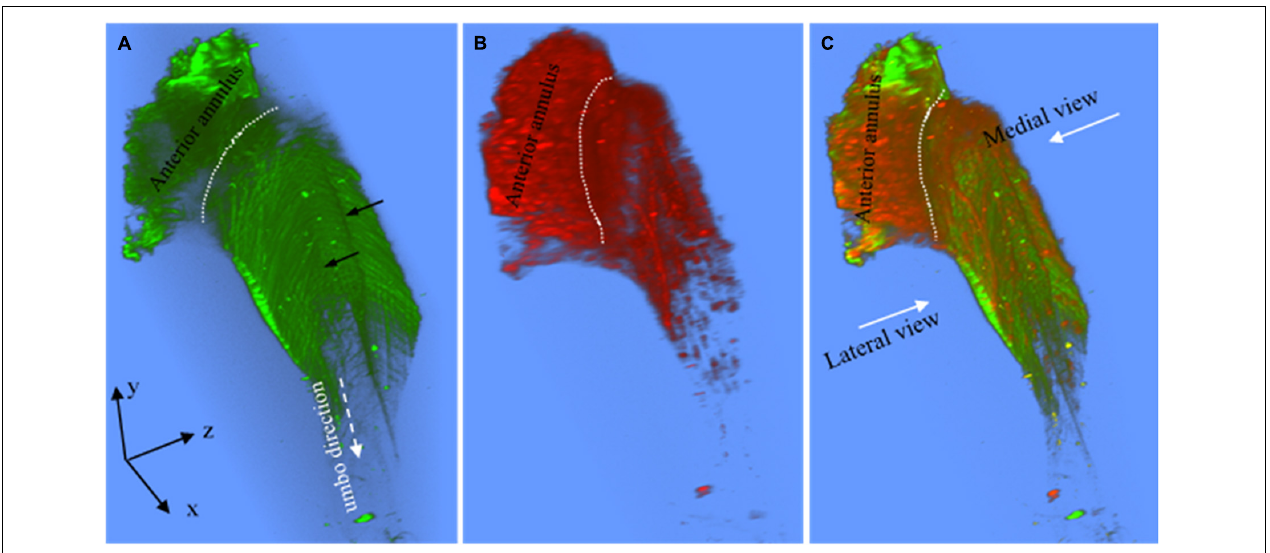
FIGURE 3 | (A) The superior view of the 3D collagen scaffold (green) of the anterior pars tensa-annulus unit. The collagen scaffold in the pars tensa has a notable waveform contour (black arrows). (B) The corresponding TPF shows the capillary network and annulus chondrocytes of the parse tensa-annulus unit. (C) The merged image shows the capillary network (red) runs along the medial side and conforms to the collagen network (green). Field of the view: 509 × 509 µ m 2 .